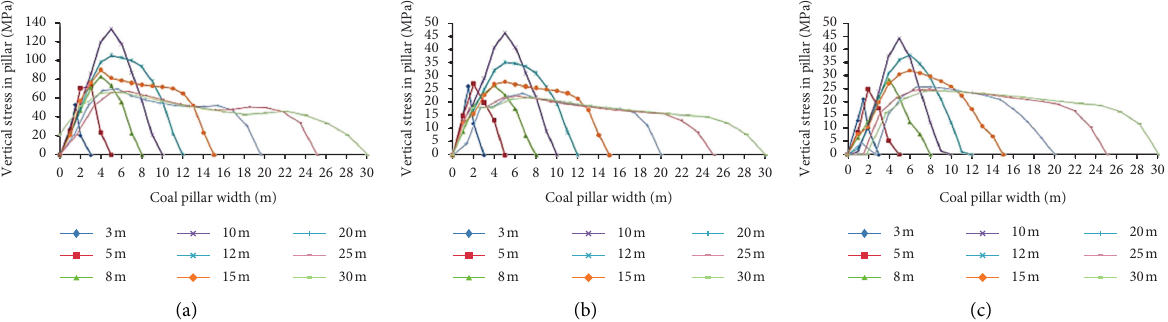
Figure 13: Stress distribution in coal pillar with different widths. (a) Vertical stress in pillar. (b) Horizontal stress in pillar (axial direction of parallel roadway). (c) Horizontal stress in pillar (vertical roadway axial direction).